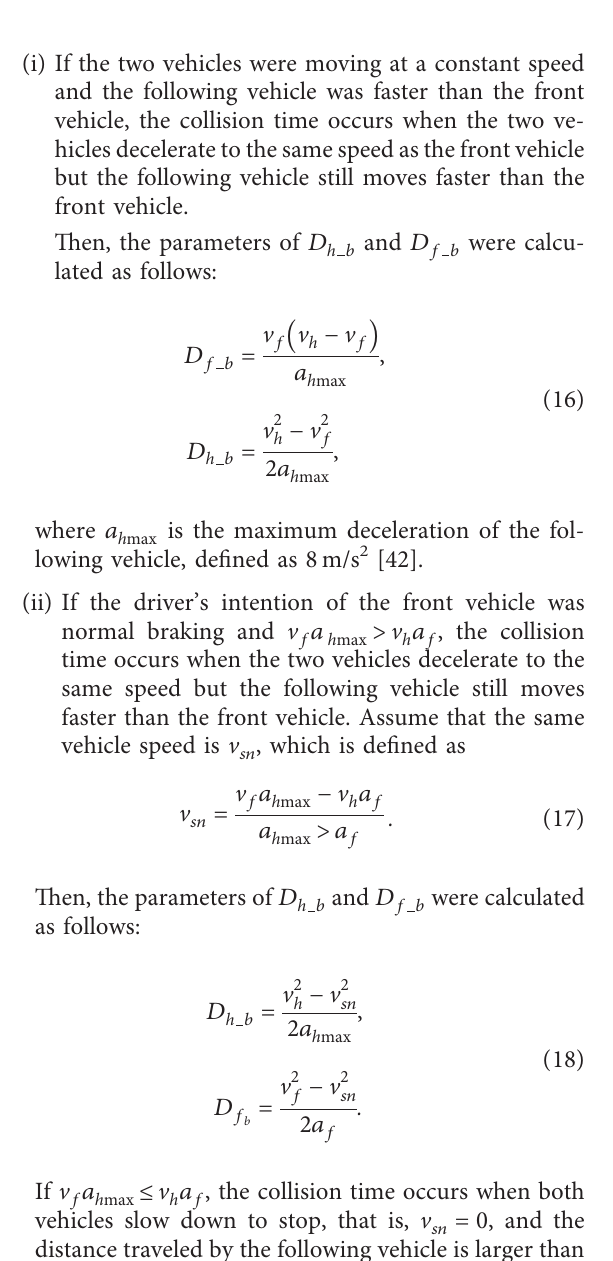
Figure 4: Critical braking distance calculation